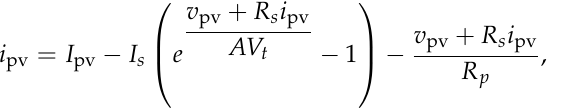
Figure 2. Two-stage grid connected PV system with a quadratic boost converter in the DC-DC